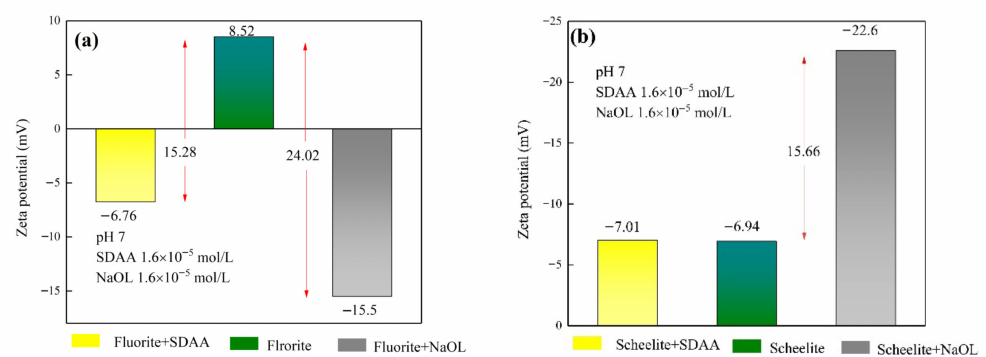
Figure 6. Zeta potentials of fluorite ( a ) and scheelite ( b ) with or without treating with SDAA or